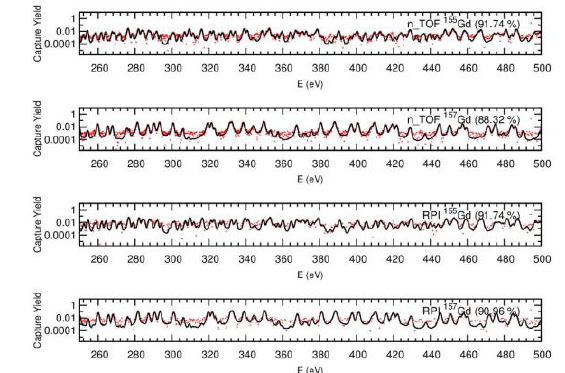
Fig. 4. Comparisons of SAMMY calculations with the resonance parameter (solid line) of the n_TOF and RPI capture yield in the energy range 250 eV to 500 eV.